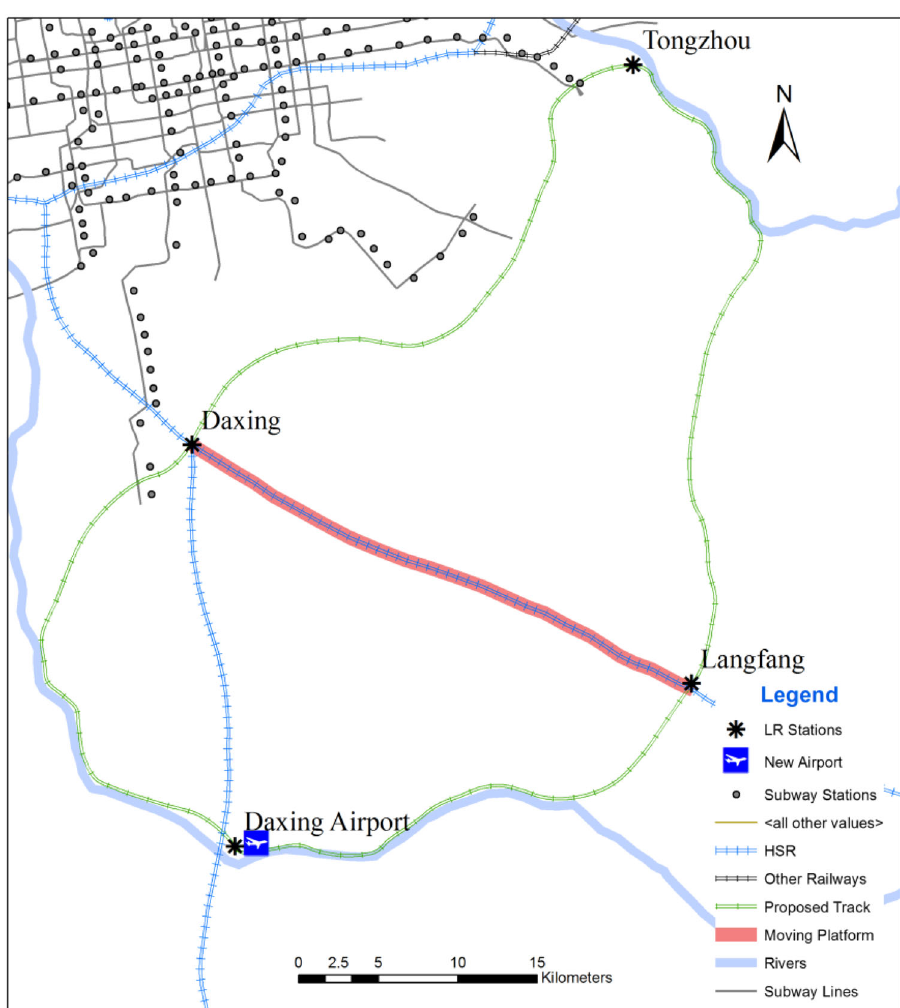
Fig. 3 Illustrative